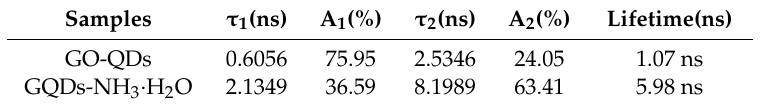
Figure 8. ( a ) Time resolved PL decay curves of GO-QDs and GQDs-NH 3 · H 2 O. ( b ) The e ff ect of di ff erent metal ions on the PL intensity of GQDs-NH 3 · H 2 O, ( c ) PL quenching of GQDs-NH 3 · H 2 O with di ff erent concentration of Cu 2 + , and ( d ) the relationship of F / F 0 and Cu 2 + concentration. Table 2. Exponential fitting results for time resolved PL decay curves of GO-QDs and GQDs-NH 3 · H 2